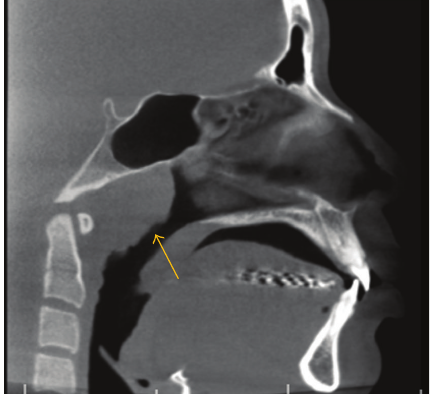
Figure 5: A sagittal view demonstrates intracranial vascular calcifi- cation. Figure 6: A sagittal view demonstrates marked adenoidal hyperpla- sia in a 16-year-old